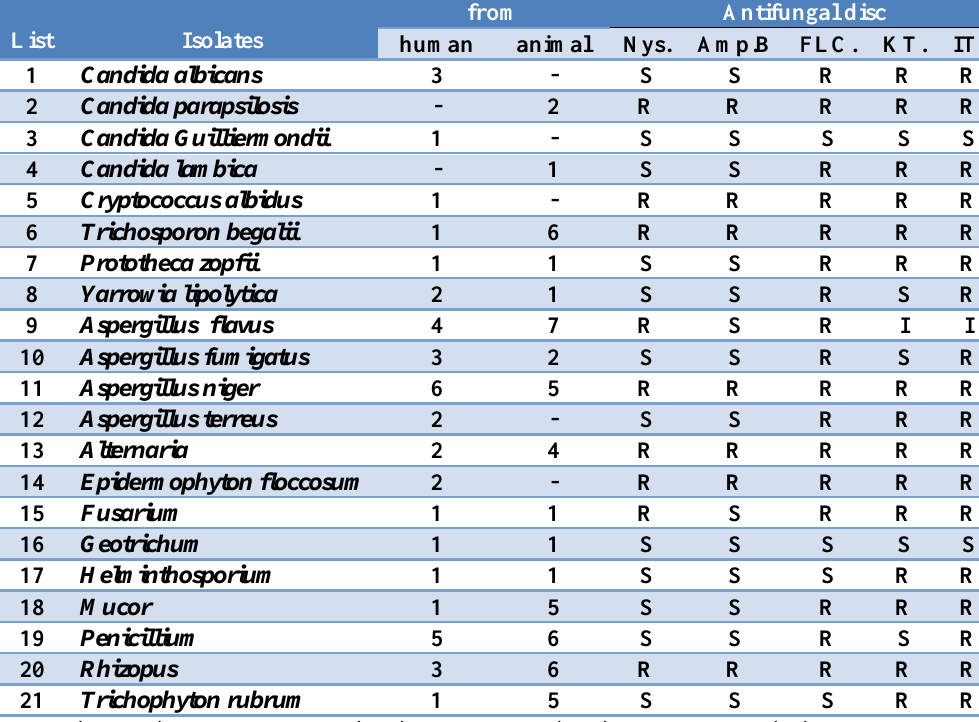
Table, 4: Show the results of antifungal disc.